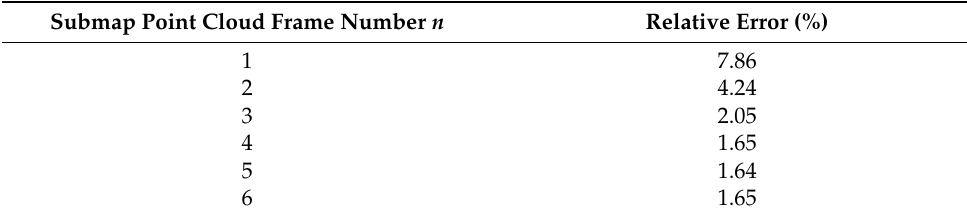
Figure 8. The number of laser frames contained in each submap. ( a ) The submap only contained one laser scan frame; ( b ) the submap only contained three laser scan frames and ( c ) the submap only contained five laser scan frames. Table 4. The number of point cloud frames contained in the submap, n , for the map quality evaluation in terms of relative error.